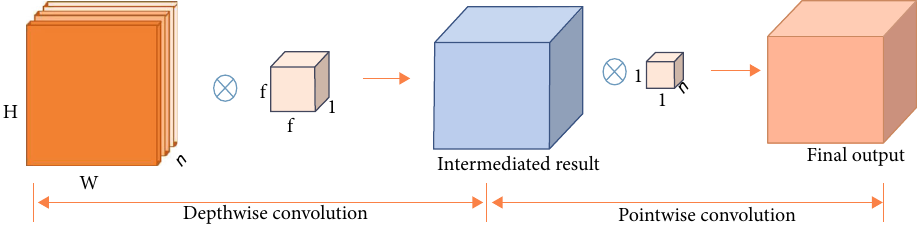
Figure 3: Schematic diagram of the separable convolution